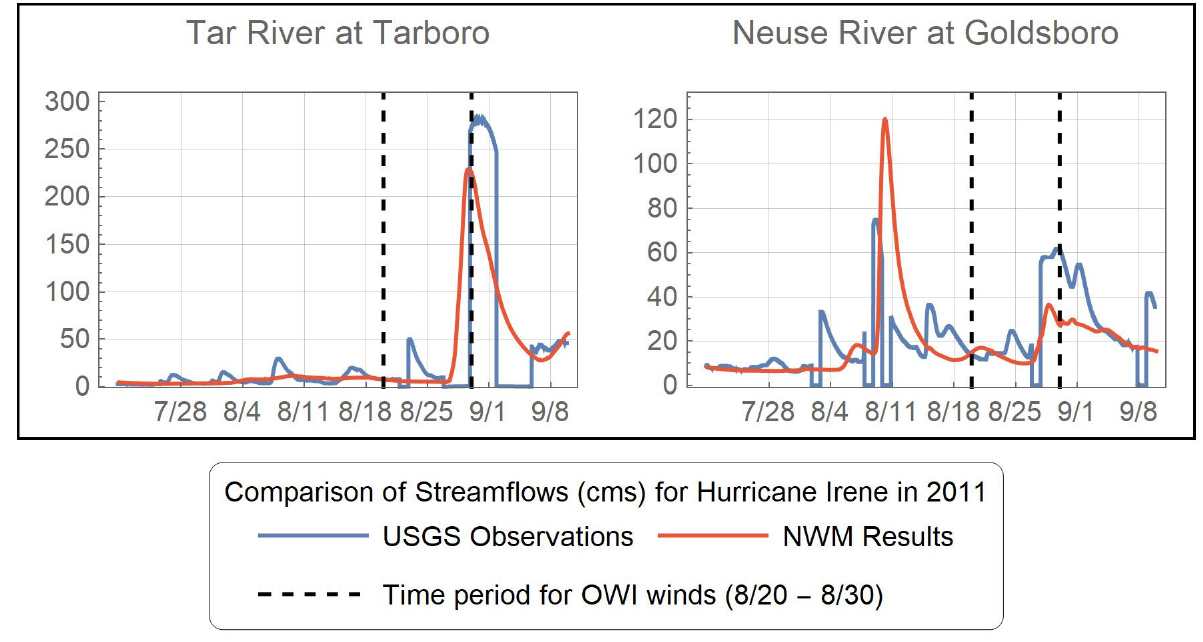
Figure 9. Comparison of observed streamflows at USGS gauging stations to simulated streamflows at the nearest available NWM location.